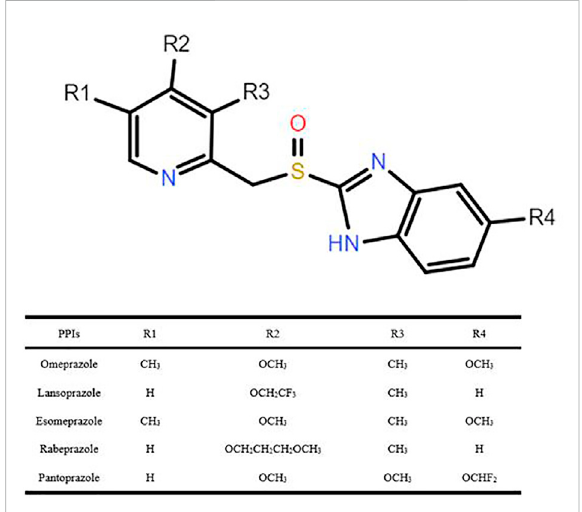
FIGURE 1 Structures of proton pump inhibitors